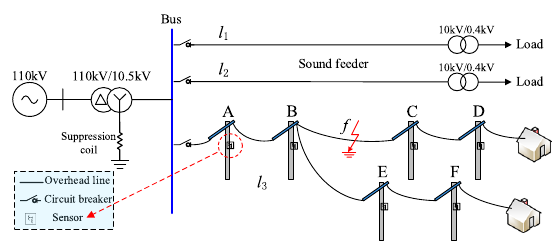
Fig. 15 10 kV distribution network Table 3 Line parameters Line type